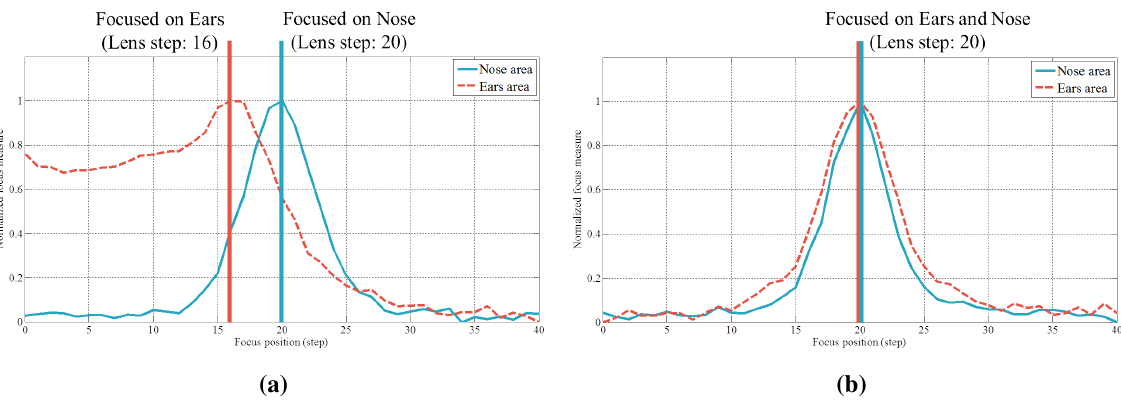
Figure 5. Variations of focus measures in accordance with lens steps (( a ) real face and ( b ) fake